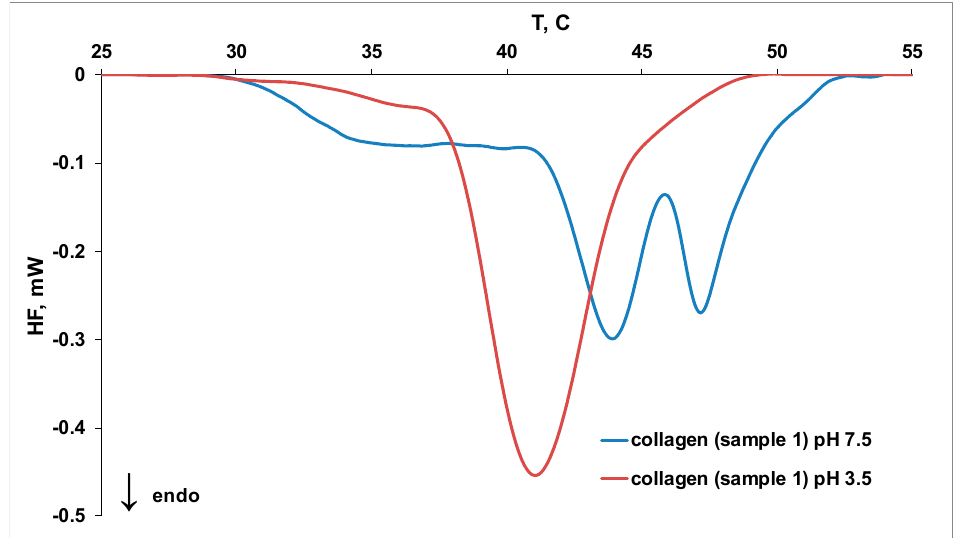
Figure 4. The DSC thermograms for thermal denaturation of sample 1 at pH 3.5 and 7.5. Higher values of peak temperatures for collagen thermal denaturation (Table 3) were obtained at pH 7.5 and suggest a higher thermal stability of triple helix (T peak2 ) and fibrillar collagen (T peak1 and T peak3 ). Table 3. Peak temperatures and denaturation heat obtained for collagen at pH 3.5 and pH 7.5.